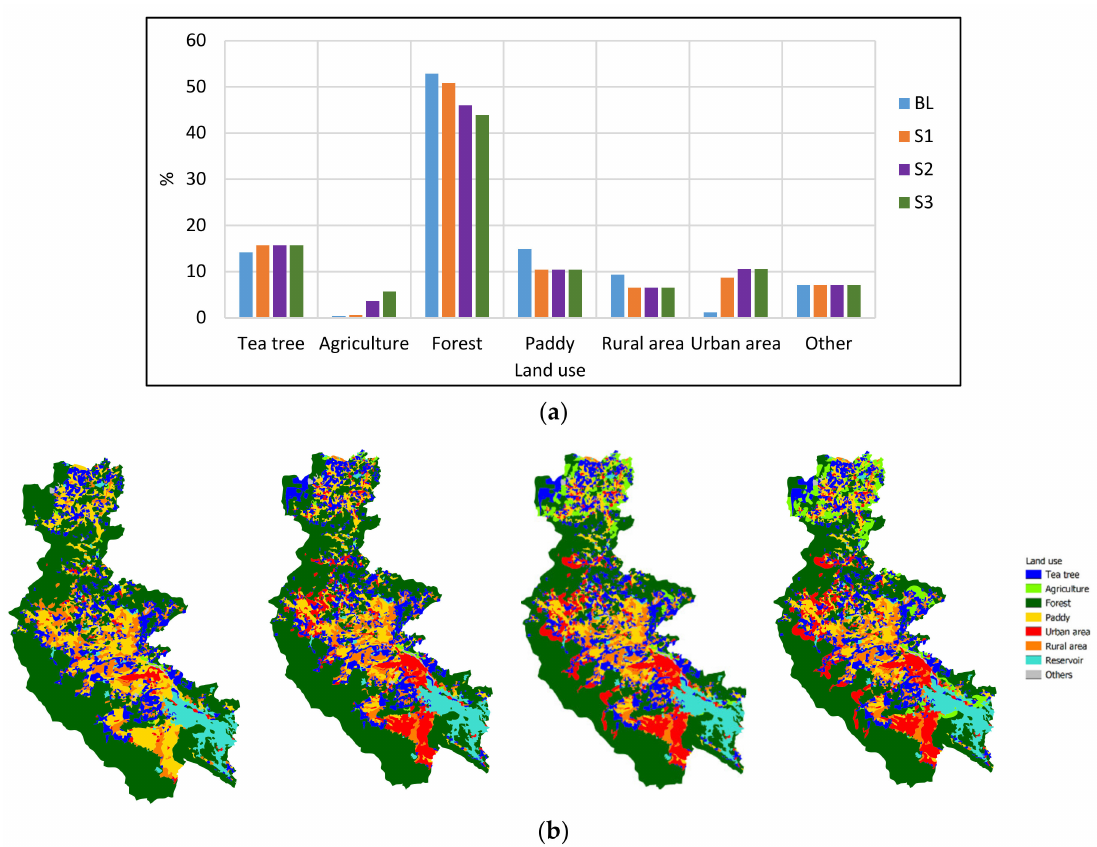
Figure 4. Percentage of each land-use in the baseline and land-use change scenarios ( a ); BL and projected scenarios of LULC change ( b